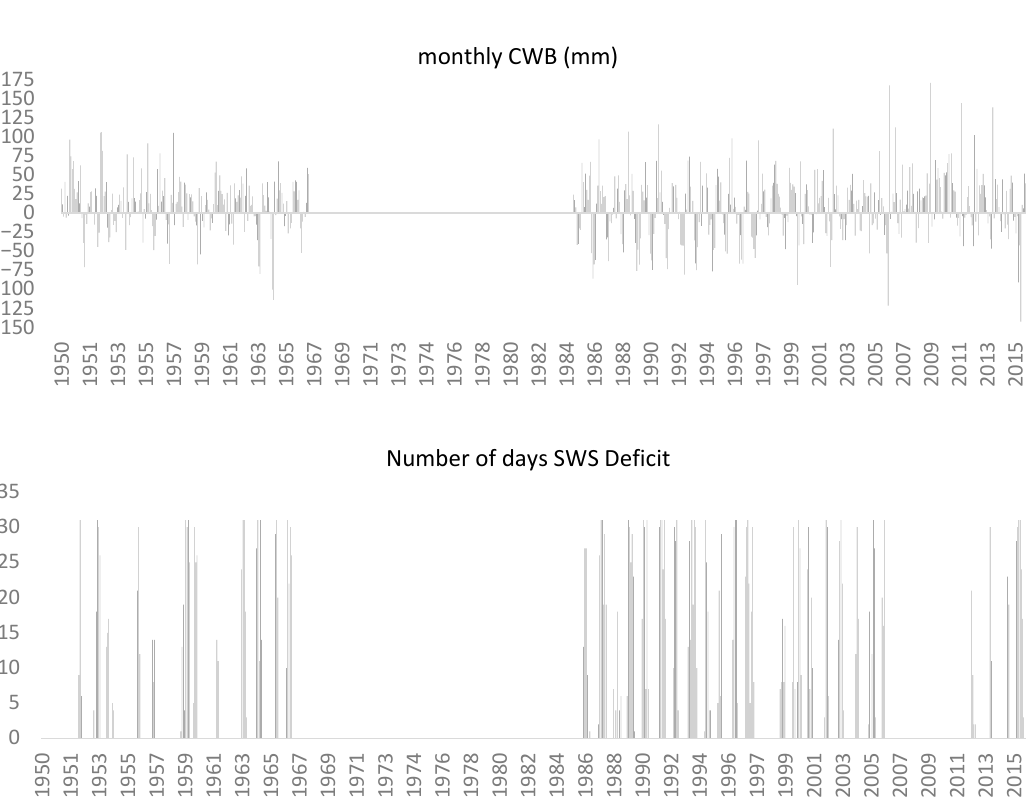
Figure 4. Drought indices from 1950 to 2015 in Bialowieza. PDSI—Palmer Drought Severity Index, SPI—Standardized Precipitation Index, CWB—Climatic Water Balance, SWS—soil water storage.